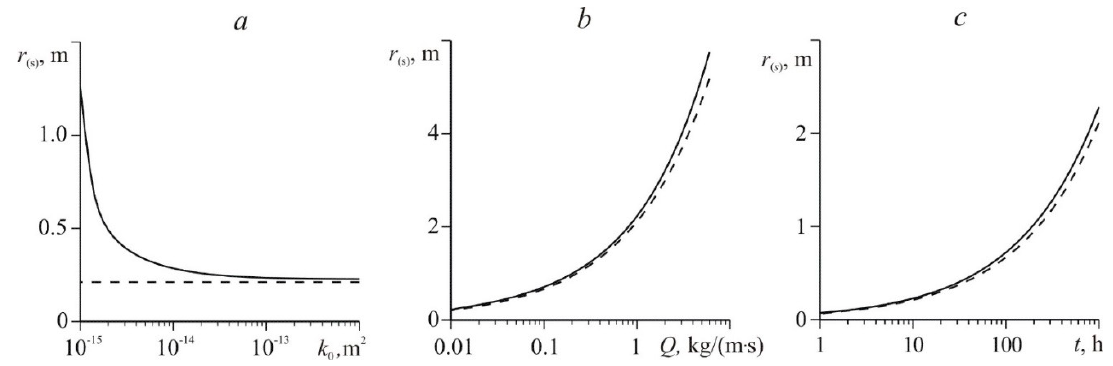
Figure 5. Change of the coordinate of the phase transition boundary depending on the permeability ( a ), mass flow rate ( b ), and time ( c ); a and c − Q = 0.01 kg/(m ∙ s), b and c − k 0 = 10 − 12 m 2 ; other parameters correspond to Figure 2.